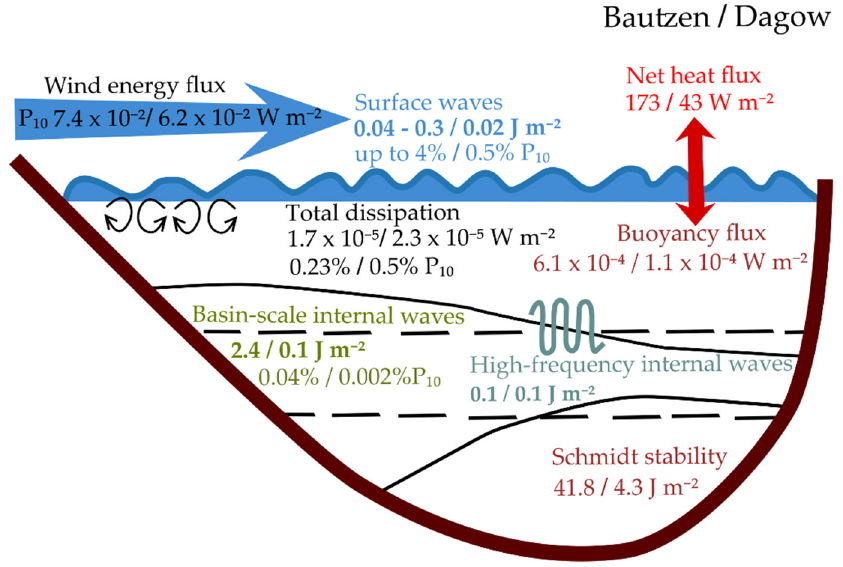
Figure 8. Scheme showing mean energy fluxes in (W m − 2 ) and mean energy content (J m − 2 ) for the two studied water bodies. Numbers written before/after a slash correspond to the values obtained from Bautzen Reservoir and Lake Dagow measurements, respectively. Solid and dashed lines illustrate the motion and equilibrium positions of vertical layers of water with the same density.